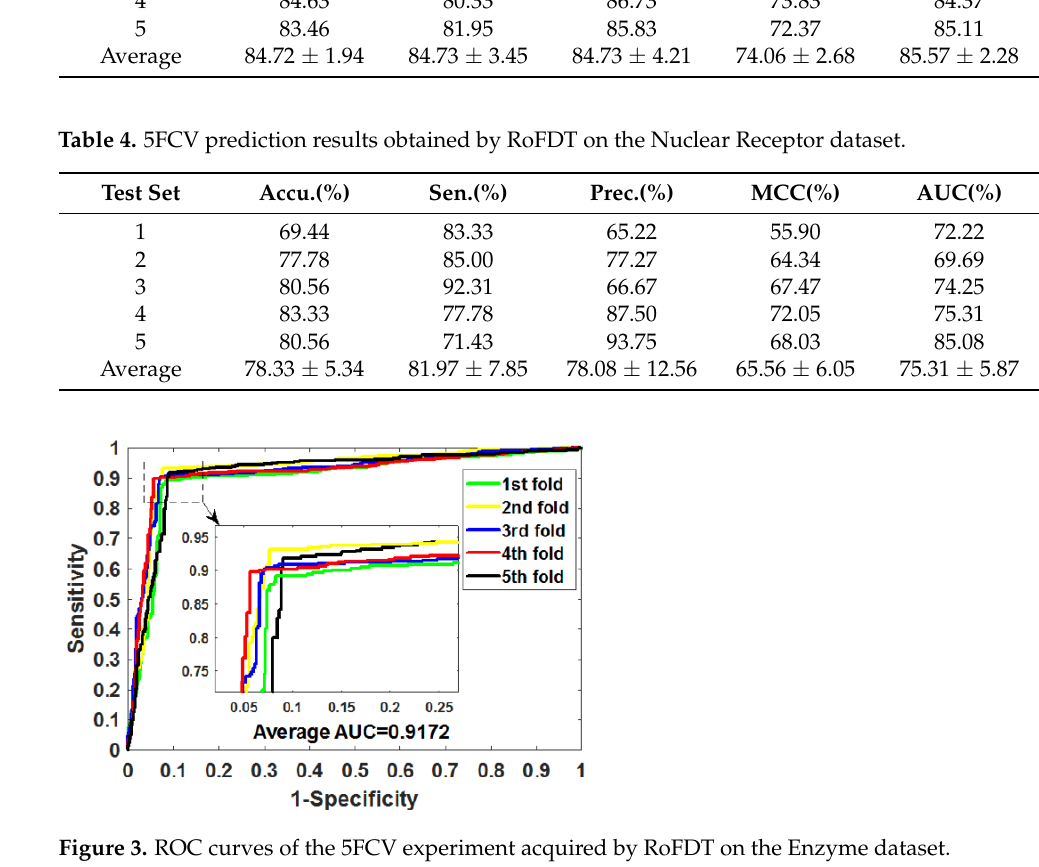
Table 2. 5FCV prediction results obtained by RoFDT on the Ion Channel dataset.